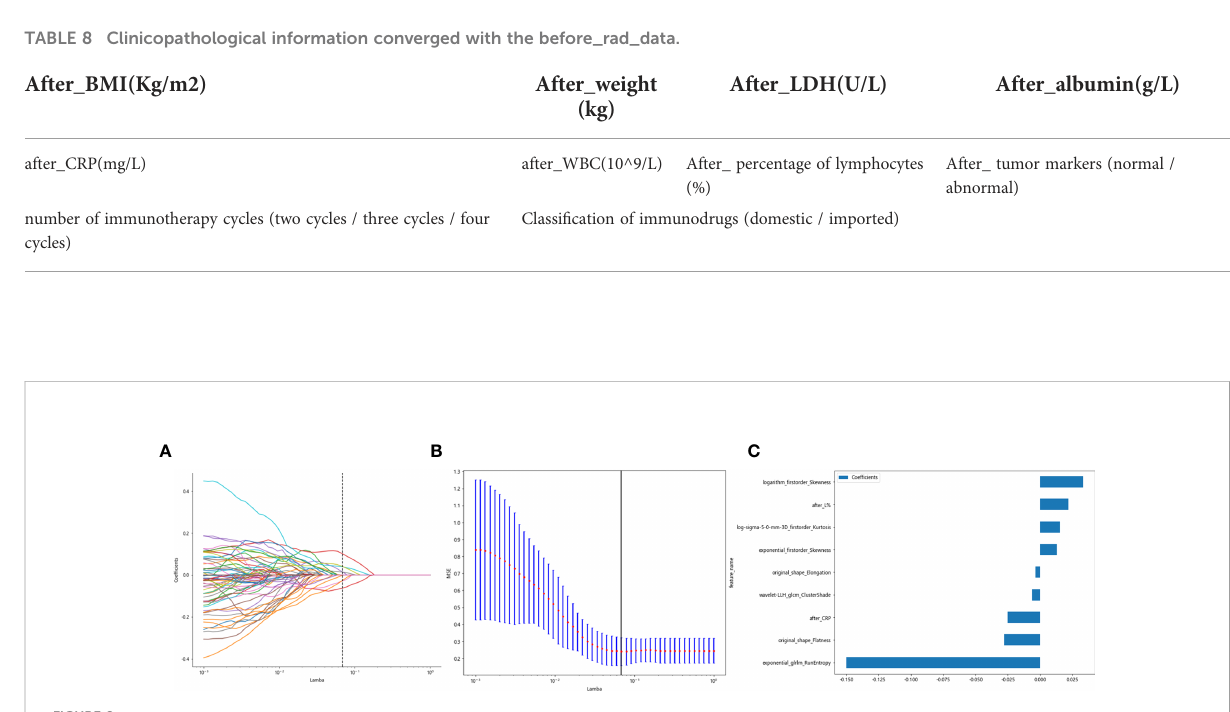
FIGURE 8 Regression feature screening. (A) Feature selection plot for the LASSO regression, which was adjusted by a super parameter (Lamba), to achieve the purpose of screening the optimal features. The vertical dashed line indicates that the corresponding optimal Lamba value when obtaining the minimum deviation value is Lamba = 0.06866. (B) The convergence graph of characteristic coef fi cients for feature selection by cross-validation. Features with non-zero coef fi cients were screened out corresponding to the vertical lines in the plot, with a total of nine best features selected. (C) Twelve features and weights of LASSO regression screening. The nine features screened were “ exponential_ fi rstorder_Skewness, ” “ exponential_glrlm_RunEntropy, ” “ log-sigma-5-0-mm-3D_ fi rstorder_Kurtosis, ” “ logarithm_ fi rstorder_Skewness, ” “ original_shape_Elongation, ” “ original_shape_Flatness, ” “ wavelet-LLH_glcm_ClusterShade, ” “ after_CRP, ” and “ after_percentage of lymphocytes ” .